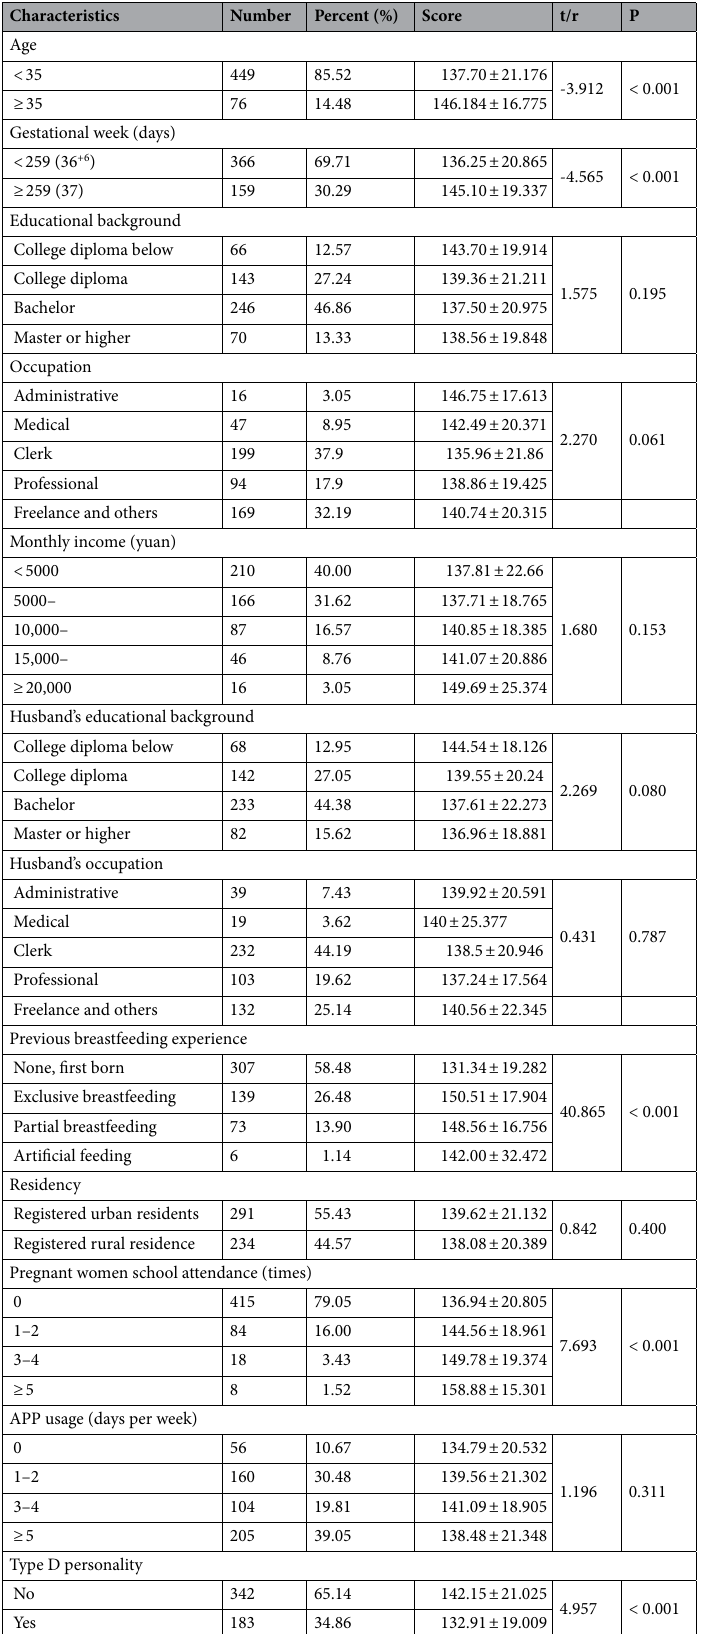
Table 1. Univariate analysis of breastfeeding competency level (n =